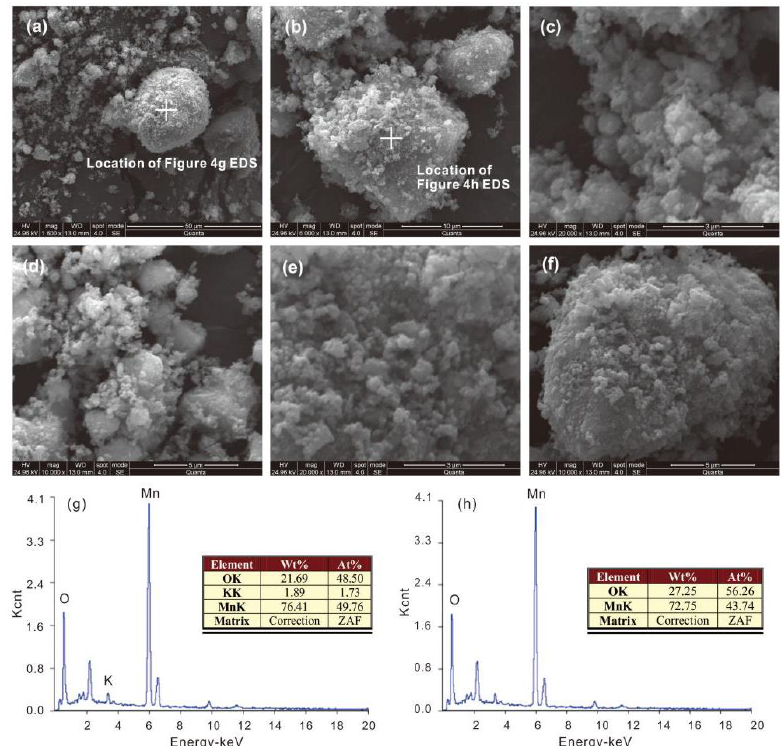
Figure 5. SEM images and EDS results of Mn-oxide powder in the Xialei deposit. ( a – f ) are SEM images; ( g , h ) are the EDS results (analyzed points shown in ( a , b ) correspondingly).